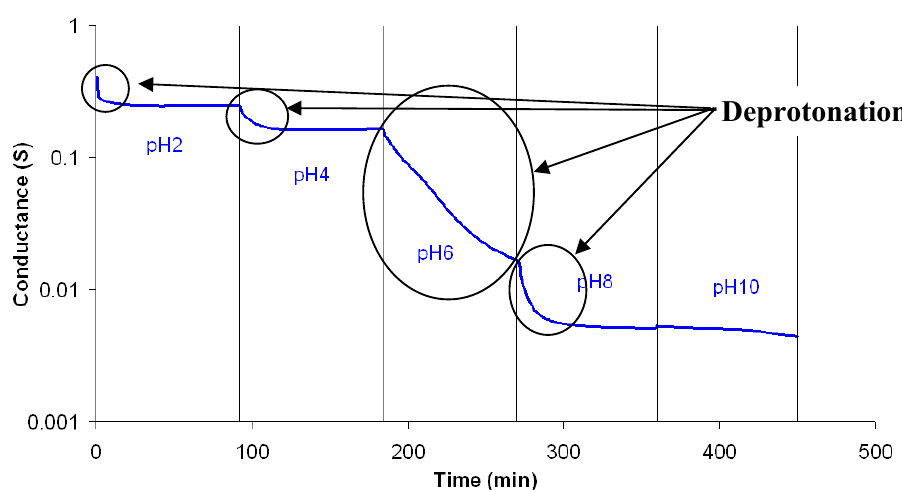
Figure 11. Plot showing the change in conductance of 120 µm PANI composite thick films when films are in contact with the test solutions for 90